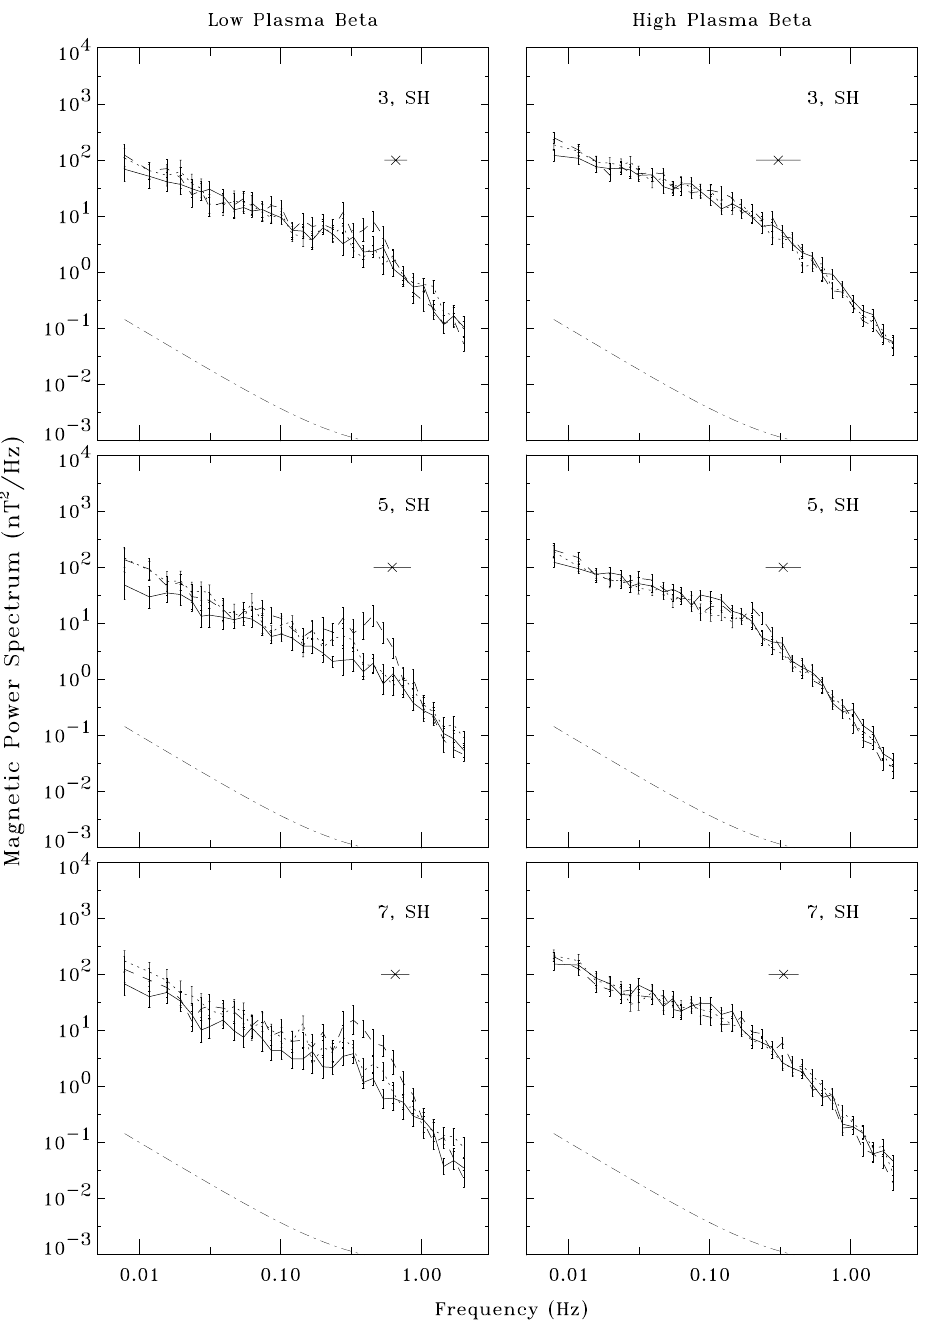
Fig. 5. Superposed-epoch analysis of magnetic power spectra downstream of 20 quasi-perpendicular low- β and 47 quasi-perpendicular high- β bow shock crossings. Same format as Fig.